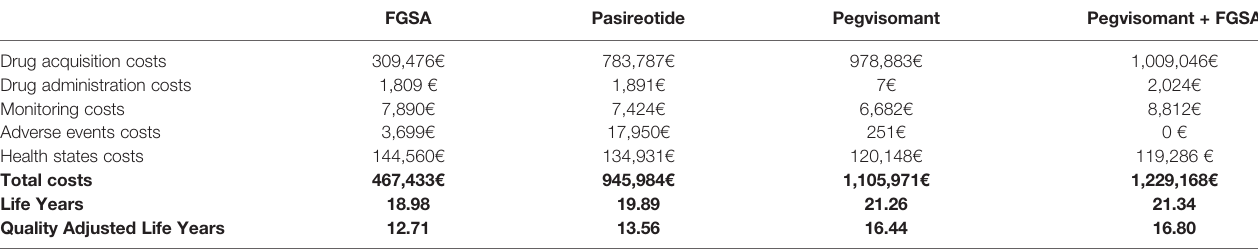
TABLE 6 | Costs, LY and QALY.